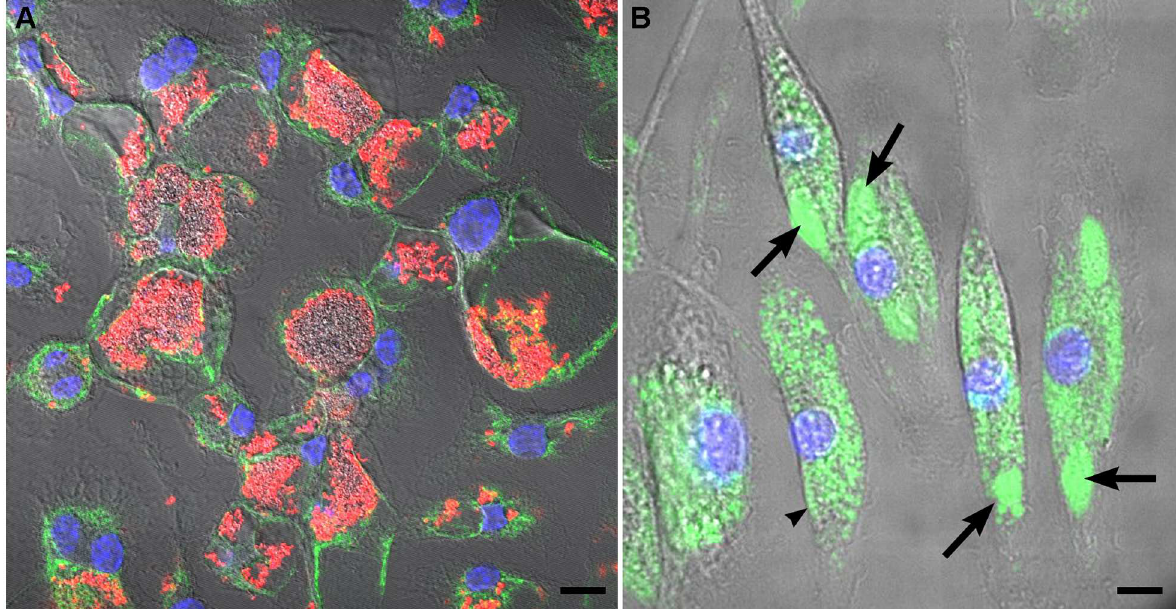
Fig 2. The NMII-occupied vacuole of C57BL/6J BMDM has lysosomal characteristics. (A) BMDM infected for 3 days and stainedfor NMII (red), LAMP1 (green), and DNA (blue). (B) BMDM infected for 3 days and incubatedwith DQ Green BSA to detect lysosomal proteolytic activity (green). Arrows denote Coxiella -containingvacuoles. An arrowheaddemarks an uninfectedcell. In both panels, nuclei are stainedwith Hoescht (blue) and fluorescent images are overlaidwith the correspondingphasecontrast image. Bars, 5 μ m.